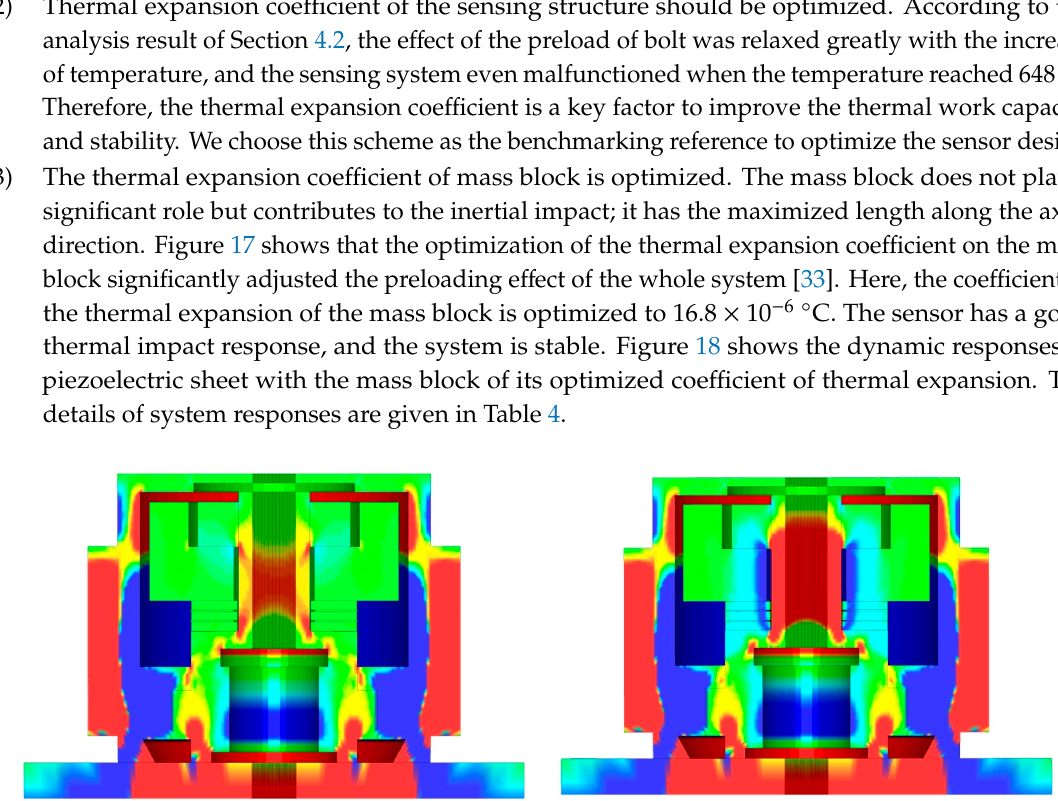
Figure 17. The contrasts of bolt stress caused by temperature of 648 °C .